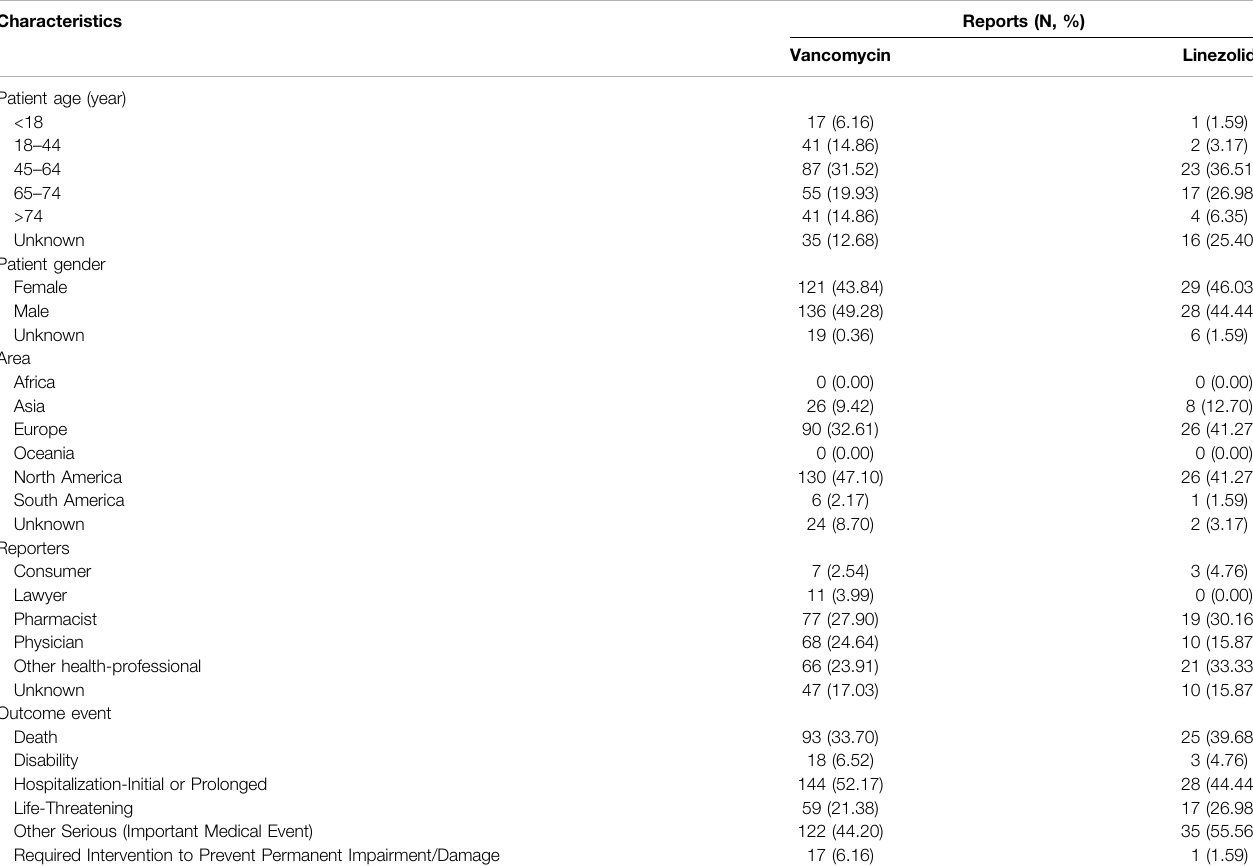
TABLE 3 | Clinical characteristics of patients with vancomycin-associated SJS and Linezolid-associated SJS collected from the FAERS database (January 2004 to July 2021).